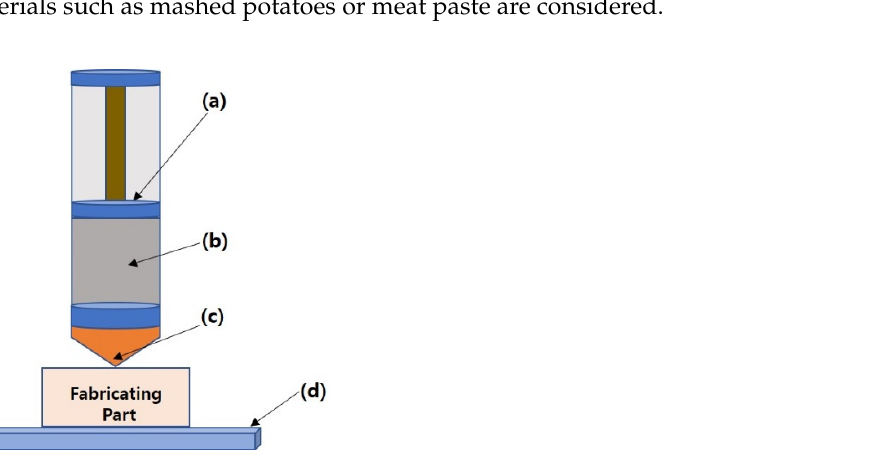
Figure 3. Scheme of extrusion-based 3D printing (a) Piston; (b) Formulated “food ink”; (c) Deposition of self-supporting layers; (d) Printer bed.